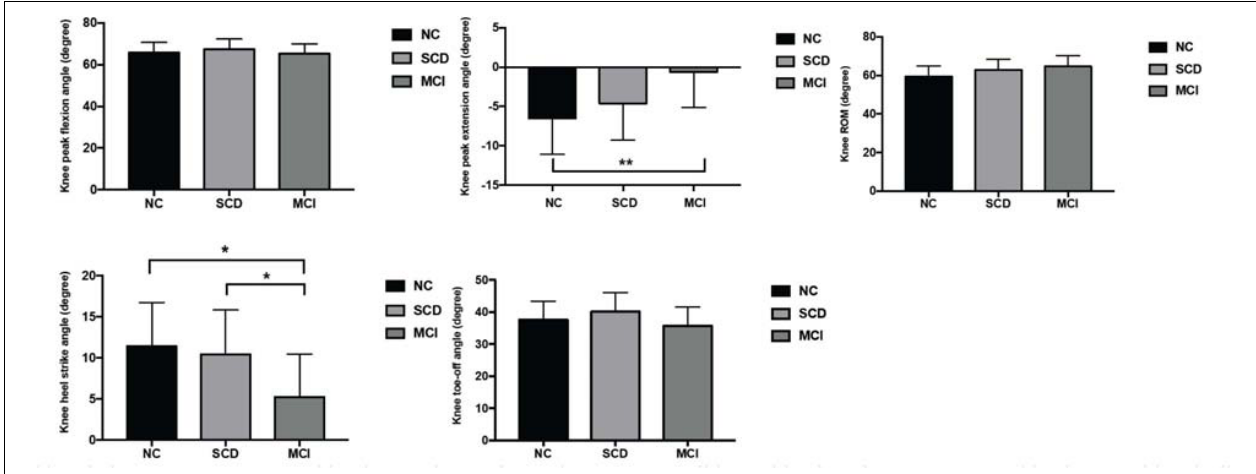
FIGURE 2 | Comparison of right knee kinematics among the three groups (MANCOVA with Bonferroni post-hoc analysis). MANCOVA, multivariate analysis of covariance; MCI, mild cognitive impairment; SCD, subjective cognitive decline; NC, normal cognition; ROM, range of motion. *A trend of difference between groups (0.0008 < p -values < 0.01 for post-hoc tests). ** p -Values < 0.0008 for post-hoc tests between MCI and NC